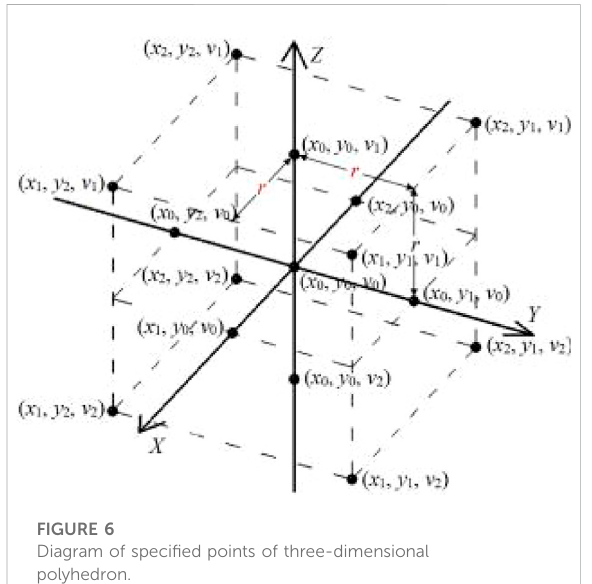
FIGURE 6 Diagram of speci fi ed points of three-dimensional